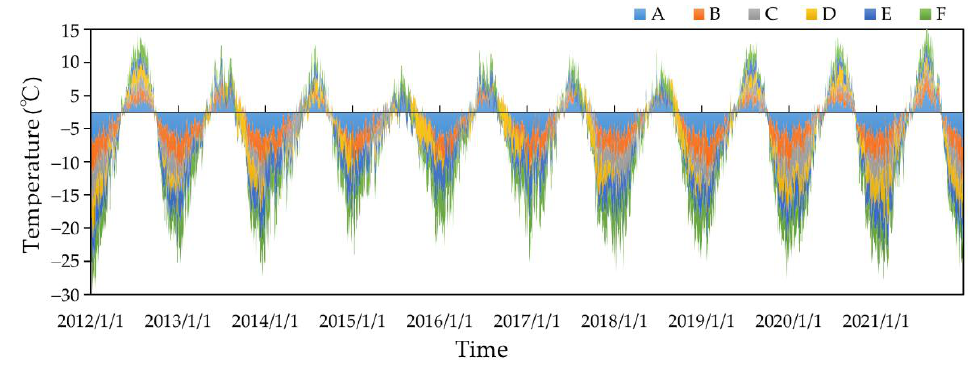
Figure 3. Daily mean air-temperature trends in the period from 2012 to 2021 in six groups A to F.